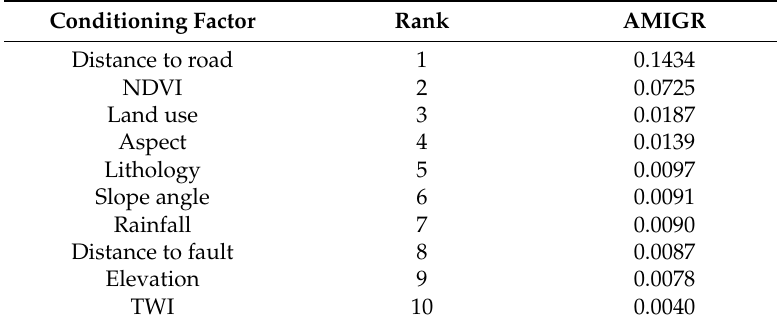
Table 3. Ranks of significant landslide conditioning factors based on the IGR technique and the training